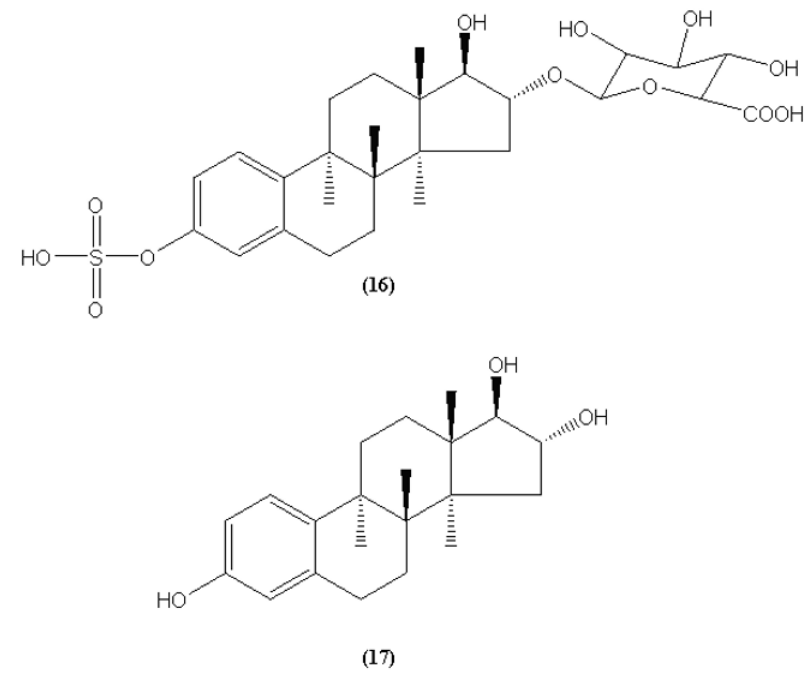
Figure 7. Structures of of estriol–3–sulfate–16–glucuronide (E3–3S–16G, 16 ) and estriol (E3, 17